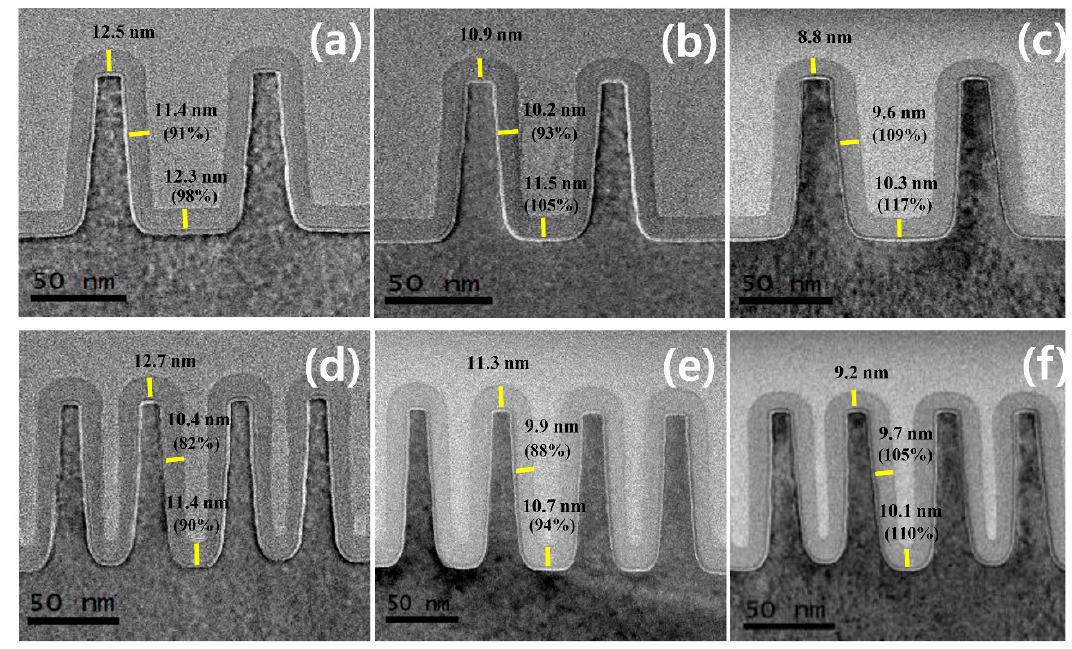
Figure 8. Cross sectional TEM images for step coverage of the RPALD SiN x film as a function of H 2 plasma exposure time in a wide pattern for ( a ) 10 s, ( b ) 20 s, and ( c ) 30 sec and in a narrow pattern for ( d ) 10 s, ( e ) 20 s, and ( f ) 30 s. All the samples were deposited at 350 °C. Table 2. Wet etch rate as a function of H 2 plasma exposure time in the three-step process. H 2 plasma Time (s) 0 10 20 30 WER (Å/min) 43 39 34 32